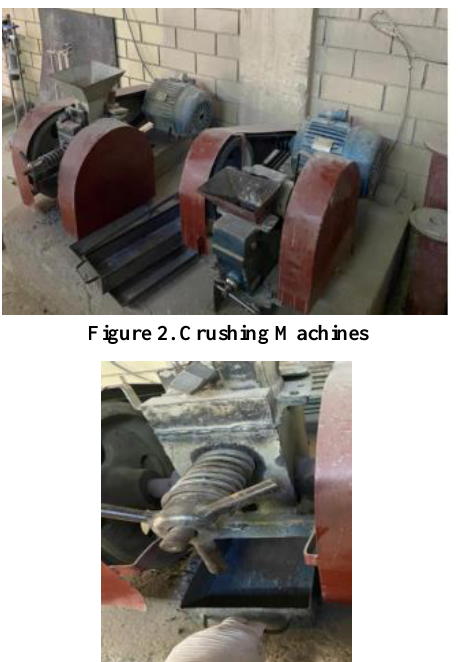
Figure 4. Crushing Machine controlling wheel Figure 5. Size of